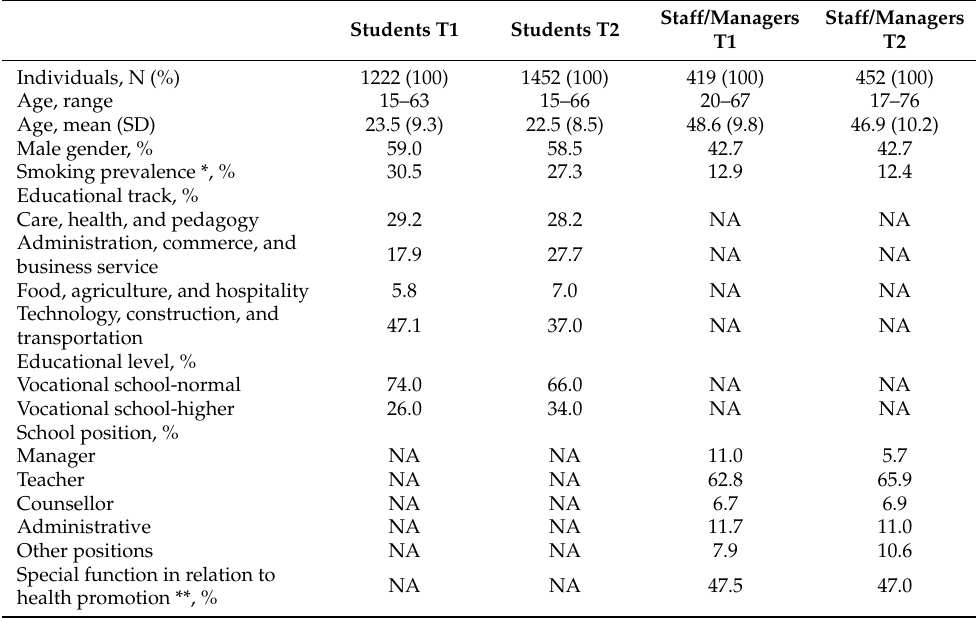
Table 4. Study population characteristics at T1 and